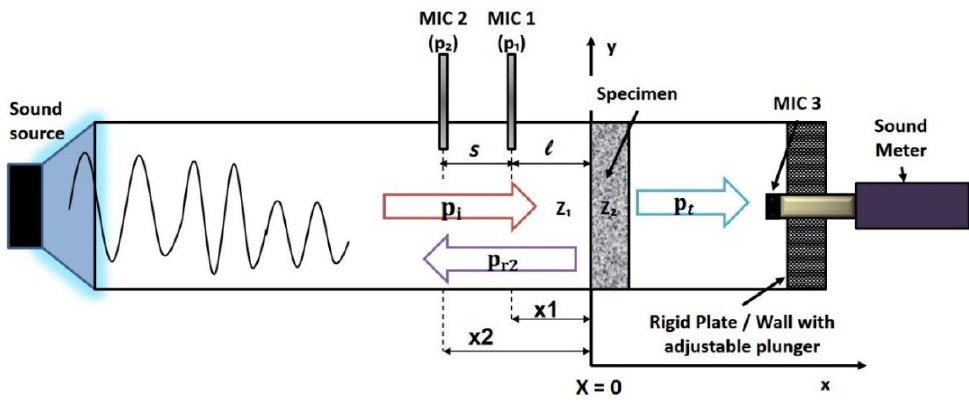
Figure 10. Schematic of “InTLM” experimental setup for transmission loss measurement using two-microphone and sound meter without the rigid wall backing.